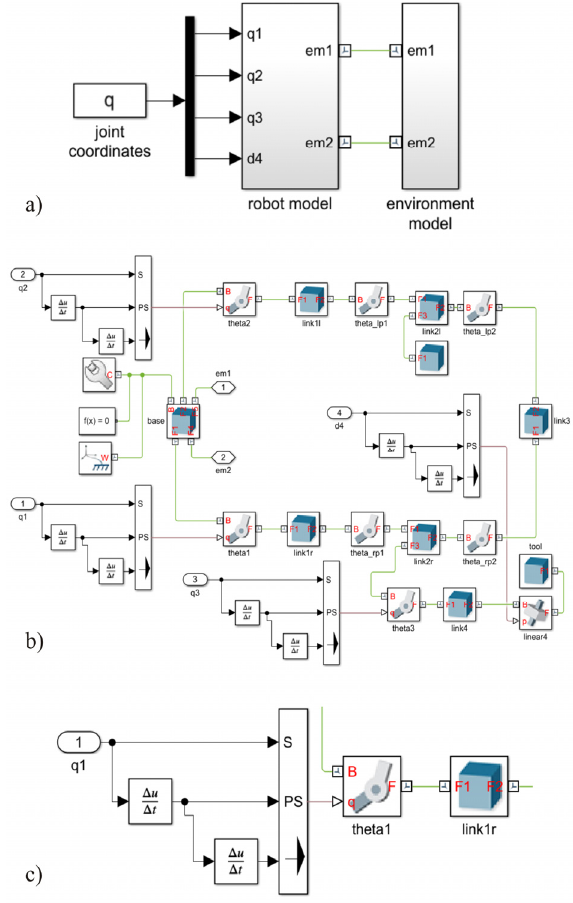
Figure 8. Simulink model of the robot The structure of configured virtual robot in Simulink is presented in Fig. 8b. It consists of a base and three kinematic chains. The base is represented with the Brick Solid element connected with World Frame , Solver Configuration , and Mechanism Configuration